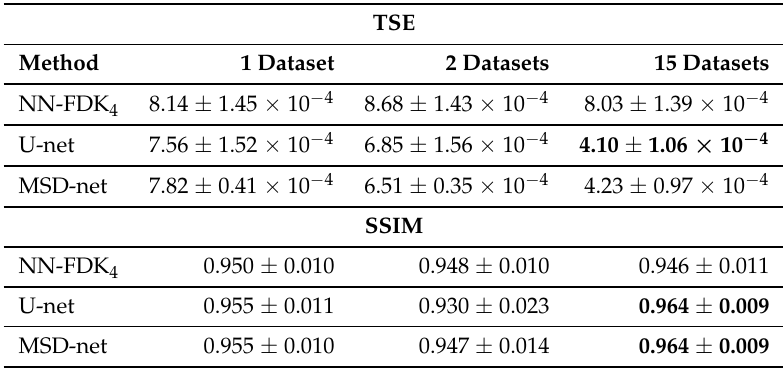
Table A2. Average and standard deviation of the quantitative measures computed over the 6 datasets for various training scenarios. These are the high-dose datasets from [56] with N a = 32 projection angles. The best results are